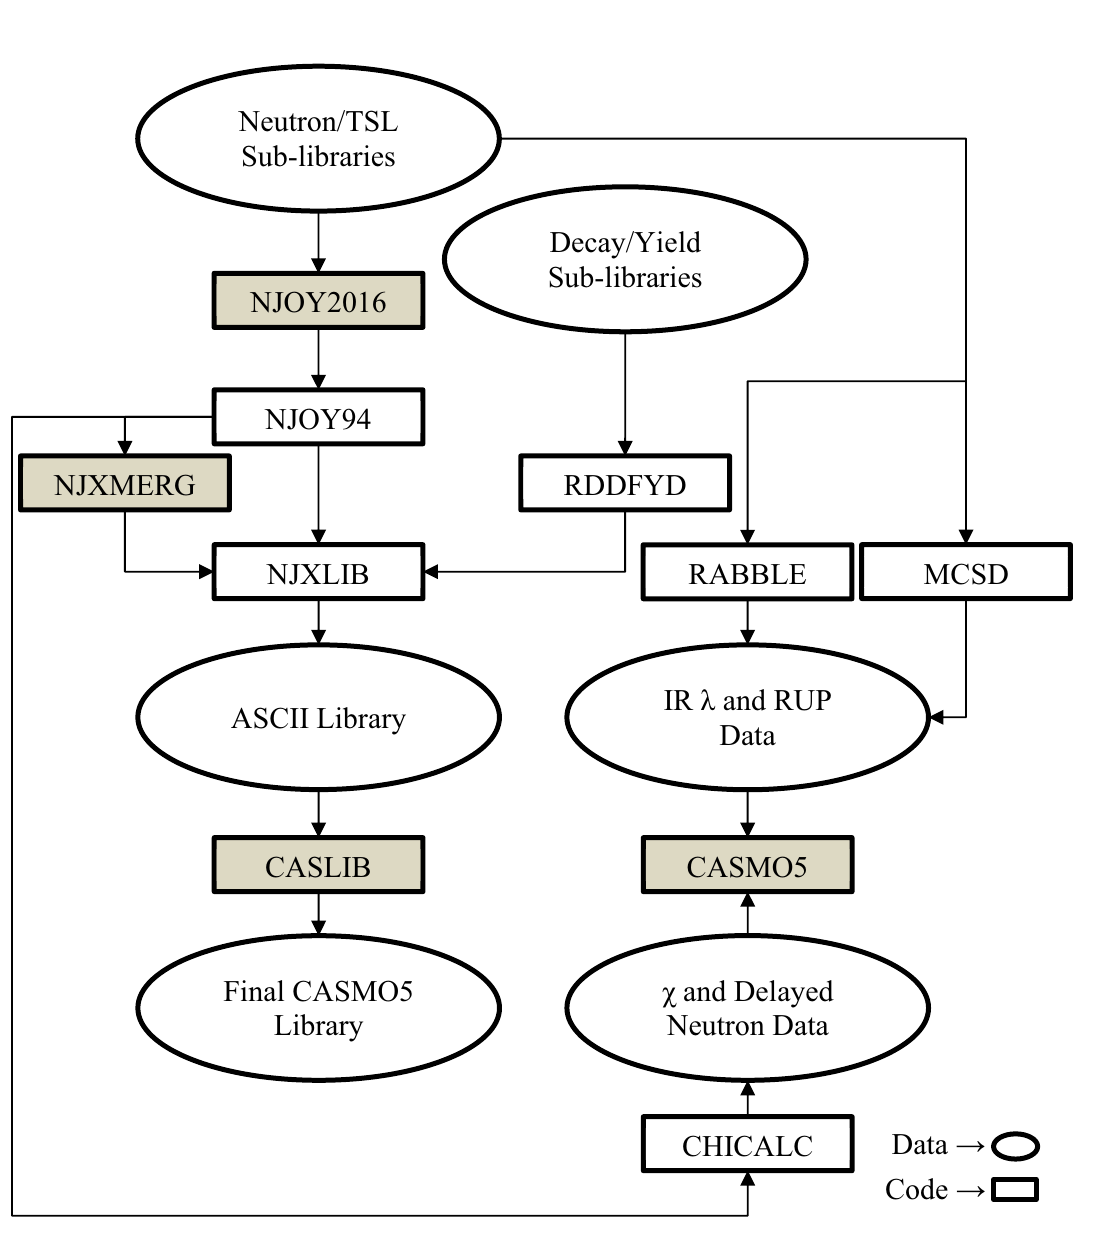
Figure 1. Updated CASMO5 library generation procedure. Codes highlighted in gray required updating to process ENDF/B-VIII.0